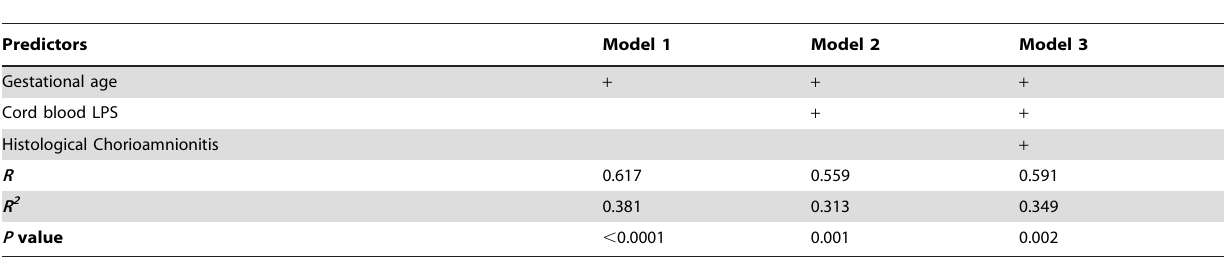
Table 3. Outcome of predictive model for Treg